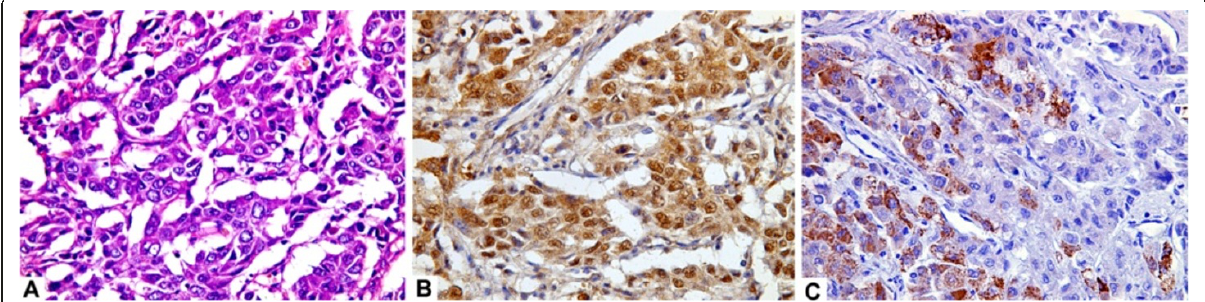
Figure 1 A case of moderately differentiated hepatocellular carcinoma (A, H&E,original magnification x400) with strong and diffuse arginase-1 staining (B; immuoperoxidase, original magnification x400) and focal HepPar-1 immunostaining (C; immuoperoxidase, original magnification